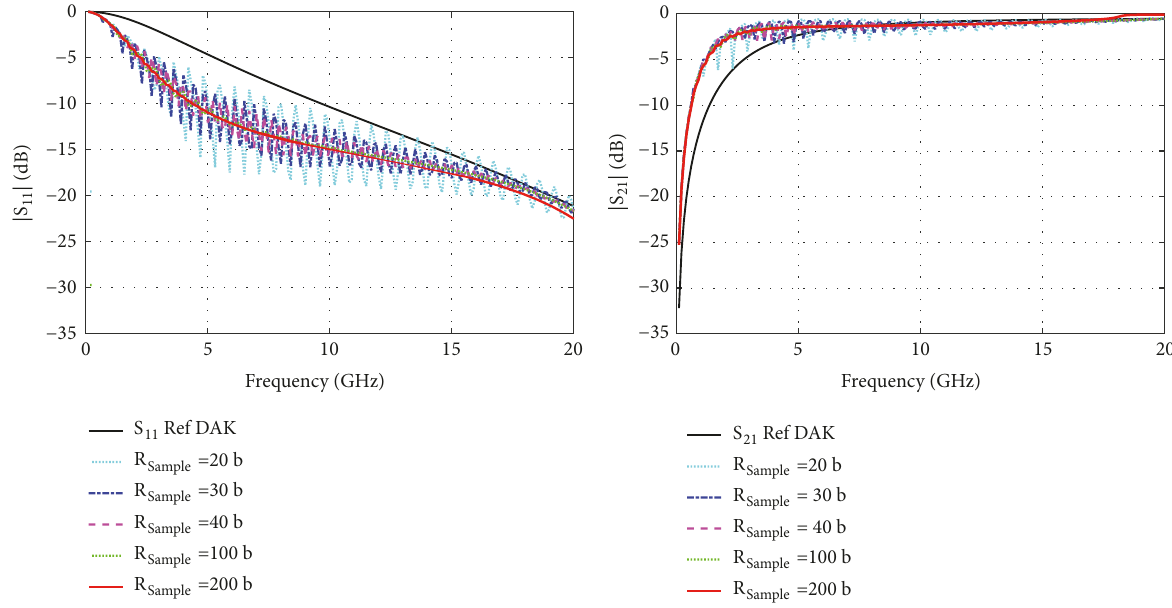
Figure 7: Magnitude (dB) of S 11 and S 21 for model A1 using only the TEM mode at the input/output coaxial lines, for different values of the virtual circular waveguide containing the sample (thickness d =0.2